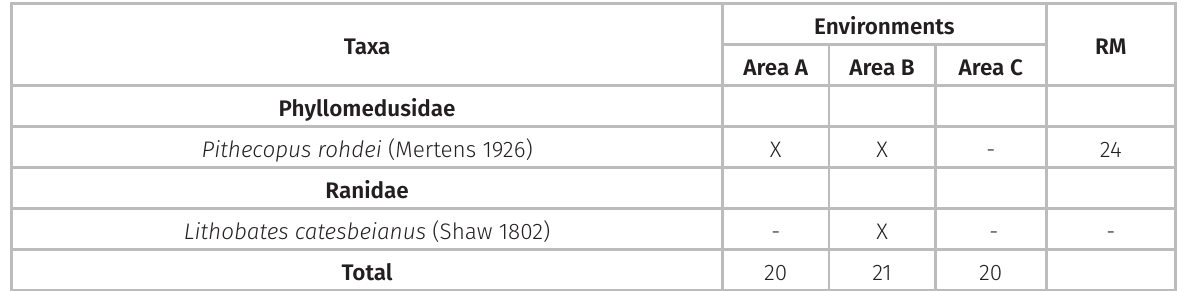
Table II. Continuation